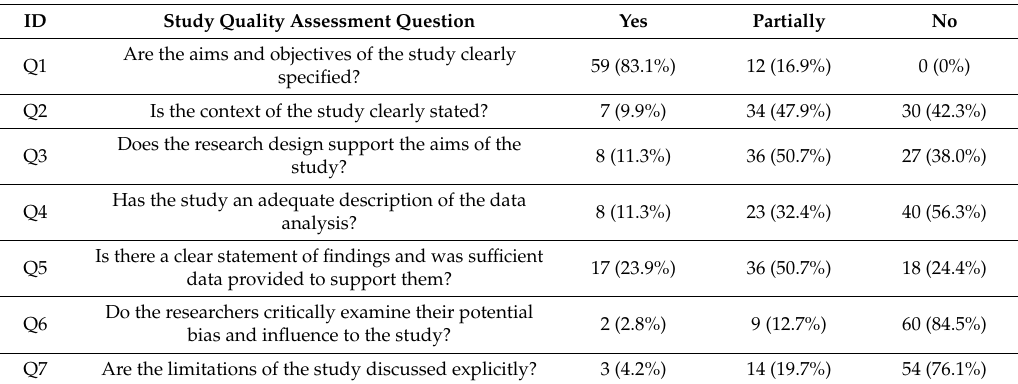
Table 9. Study quality assessment questions.